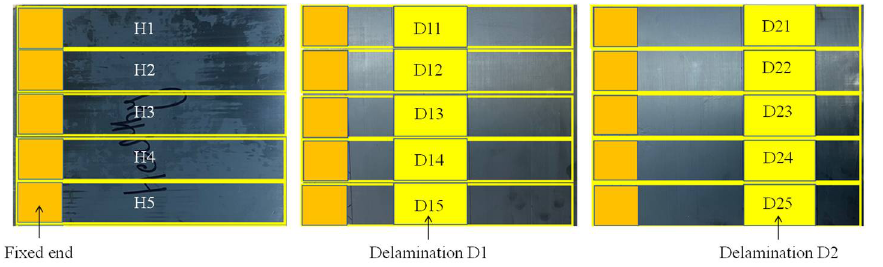
Figure 3. Healthy and delaminated samples representing three health states manufactured using a hot press machine.